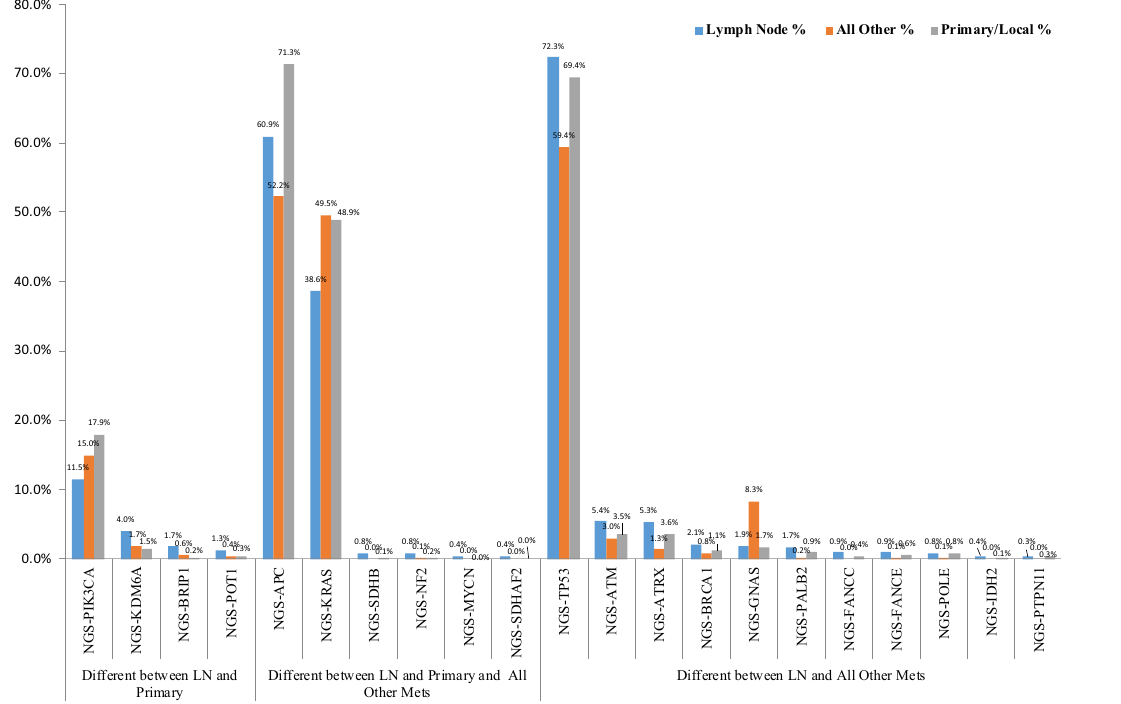
Fig. 2 Molecular differences between tumor sites. Genes with signi fi cantly different mutation frequencies between lymph nodes (LN), distant metastases (mets) and colorectal primary